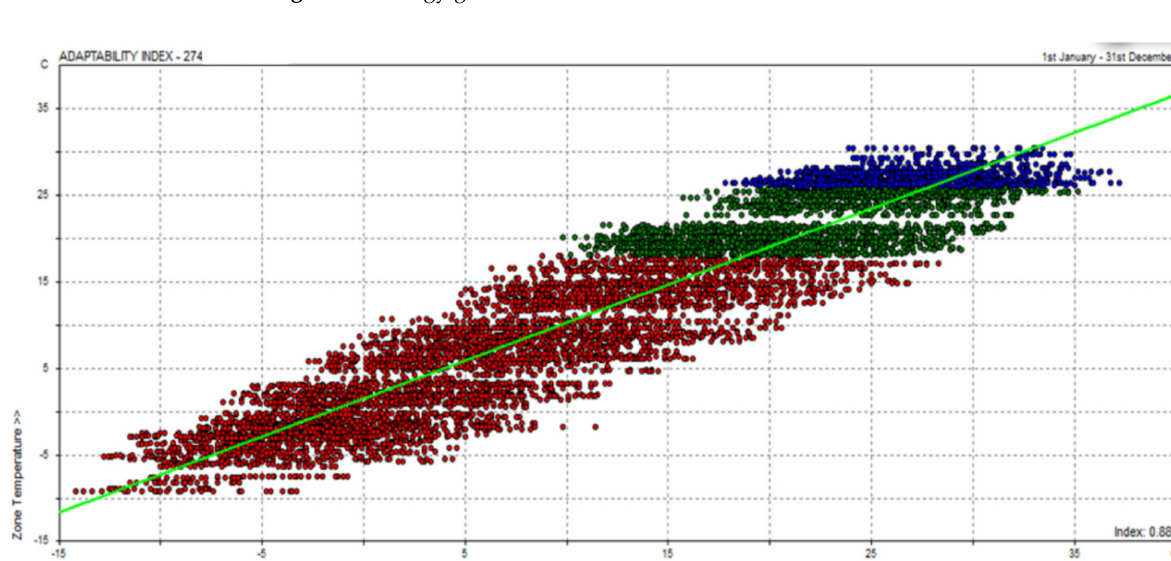
Figure 26. Thermogram of the adaptability